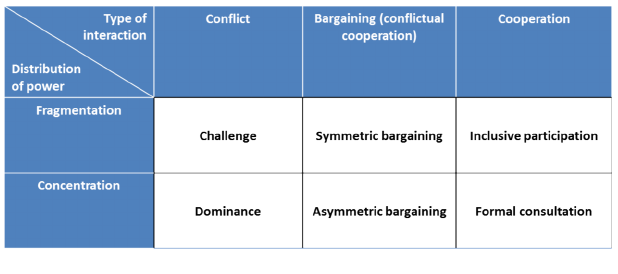
Fig. 2 . Conceptual framework: typology of power structures (adapted from Kriesi et al.